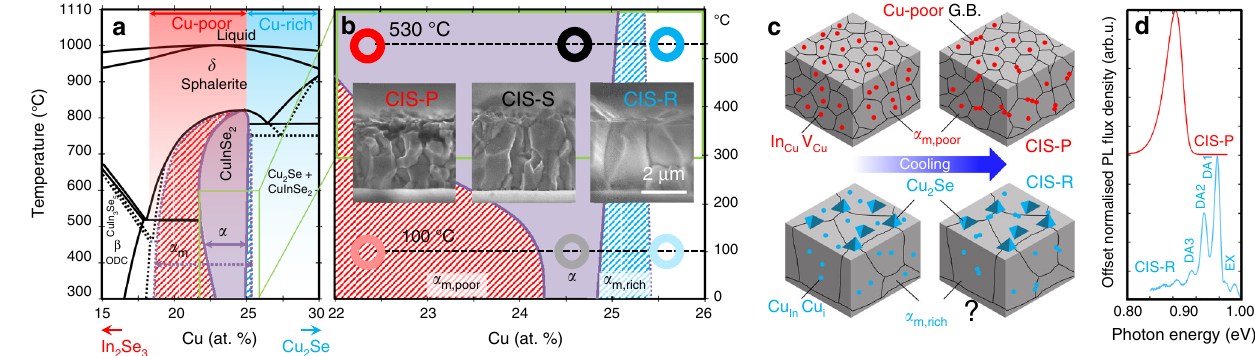
Fig. 1 CuInSe 2 phase equilibria and microstructure. a Portion of the In 2 Se 3 -Cu 2 Se pseudobinary diagram showing the stable (solid lines) and metastable (dotted lines) phase equilibria (reproduced with permission from Gödecke et al. 8 © Carl Hanser Verlag GmbH & Co.KG, München). The thin- fi lm growth regions commonly referred to as Cu-poor and Cu-rich appear at the top as red and cyan fading portions, respectively. b Magni fi cation of the phase diagram in the region of interest for CIS processing (and extension to room temperature 8 ) with hollow circles indicating the compositions investigated: CIS-P (red, Cu-poor), CIS-S (black, nearly stoichiometric) and CIS-R (cyan, Cu-rich). Insets: corresponding cross-sectional scanning electron microscopy images (CIS- R subject to KCN etching to remove the excess Cu 2 Se phase). c Schematic illustration of Cu-poor (top) and Cu-rich (bottom) fi lms after growth (left) and cool down (right). In the Cu-poor case, In Cu antisites are dispersed within the CIS lattice and part of them accumulate at grain boundaries during cool down, leading to Cu-poor grain boundaries (GB). Typical compositions of grain interiors at room-temperature match with the metastable Cu-poor region of existence, red patterned region in b . Similarly, Cu In antisites are dispersed within the CIS lattice of Cu-rich material, but Cu interstitials may also be present, possibly accounting for the enhanced grain growth during processing and for the existence of a supersaturated metastable phase at room temperature, cyan patterned region in b . d Photoluminescence spectra of CIS-P and CIS-R fi lms acquired at 10 K. Whereas CIS-R shows excitonic emissions (labelled EX, indicative of high crystal quality) and up to three donor – acceptor pair transitions (labelled DA), CIS-P shows no excitonic emissions but broader, more red- shifted and more asymmetric defect-related transitions, typical of a high degree of compensation 14